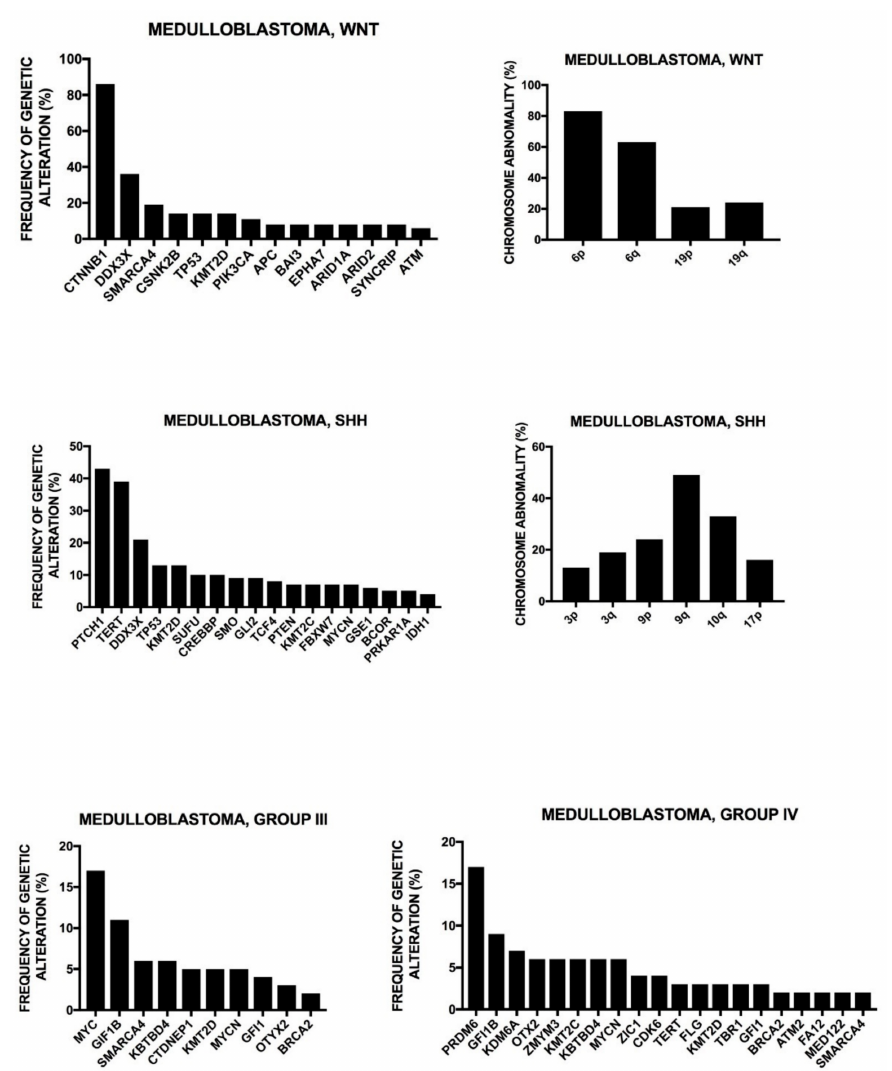
Figure 8. Subdivision of the four main medulloblastoma groups into subgroups, differentiated according to molecular, biological, and clinical features. Data reported in Northcott et al., 2017